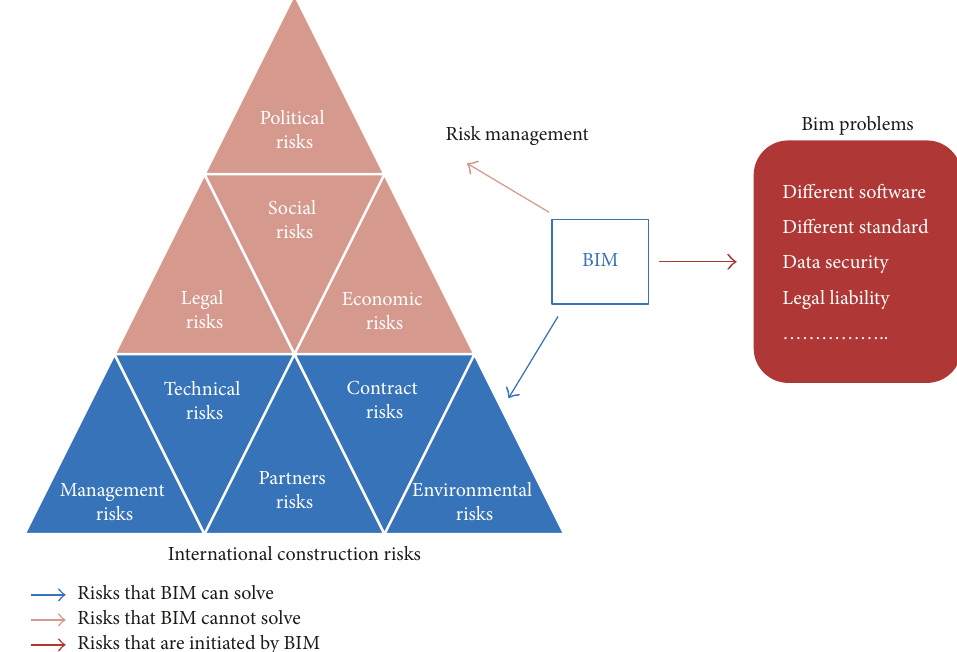
Figure 9: The proposed framework for future studies in